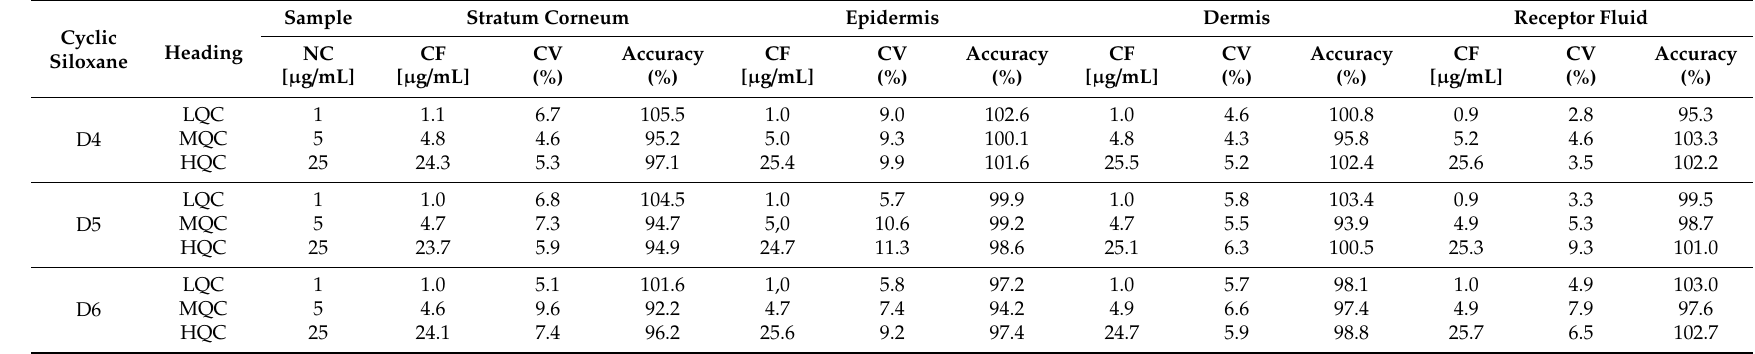
Table 4. Results of quality control and recovery (extraction e ffi ciency) of D4, D5, and D6 from the stratum corneum, epidermis, dermis, and receptor fluid, n = 6. Cyclic